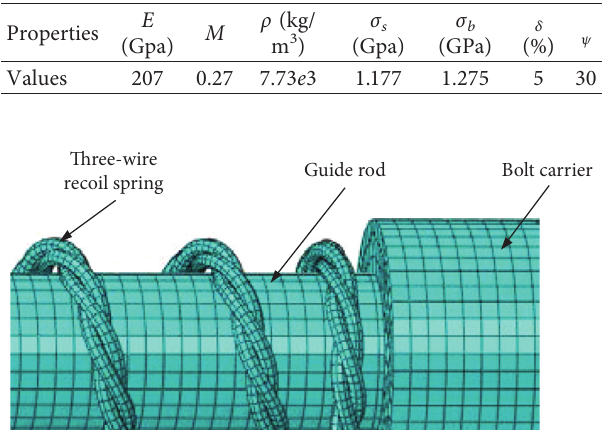
Figure 8: 55Si2Mn material performance curve. Table 3: Material parameters of 55Si2Mn.